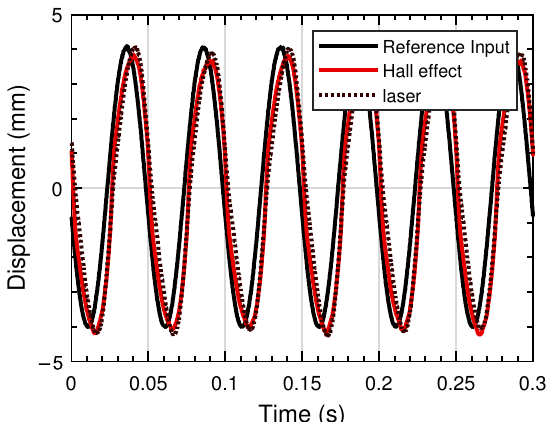
Figure 8. The plant following an oscillating reference input at 20 Hz using the calculated Hall effect Feedback compared against the laser displacement ground